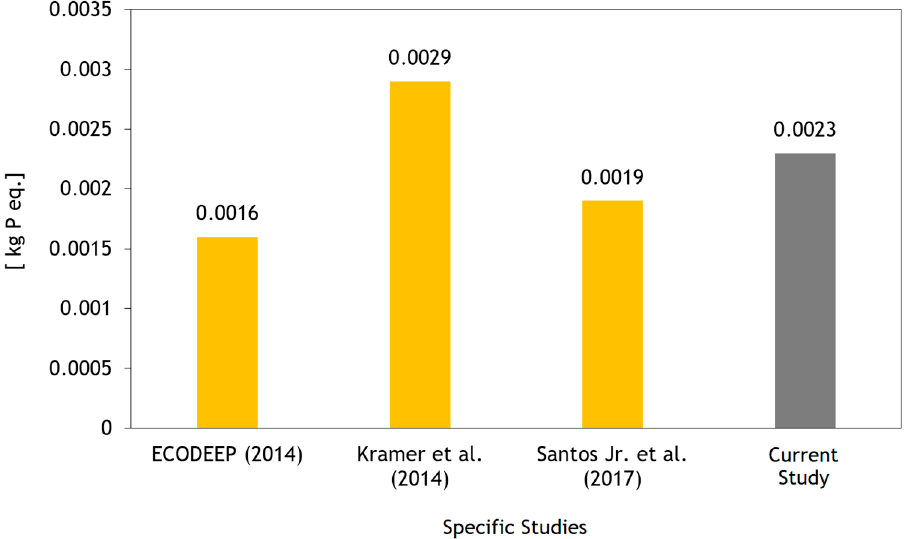
Figure 11. Freshwater eutrophication result comparison with similar studies.